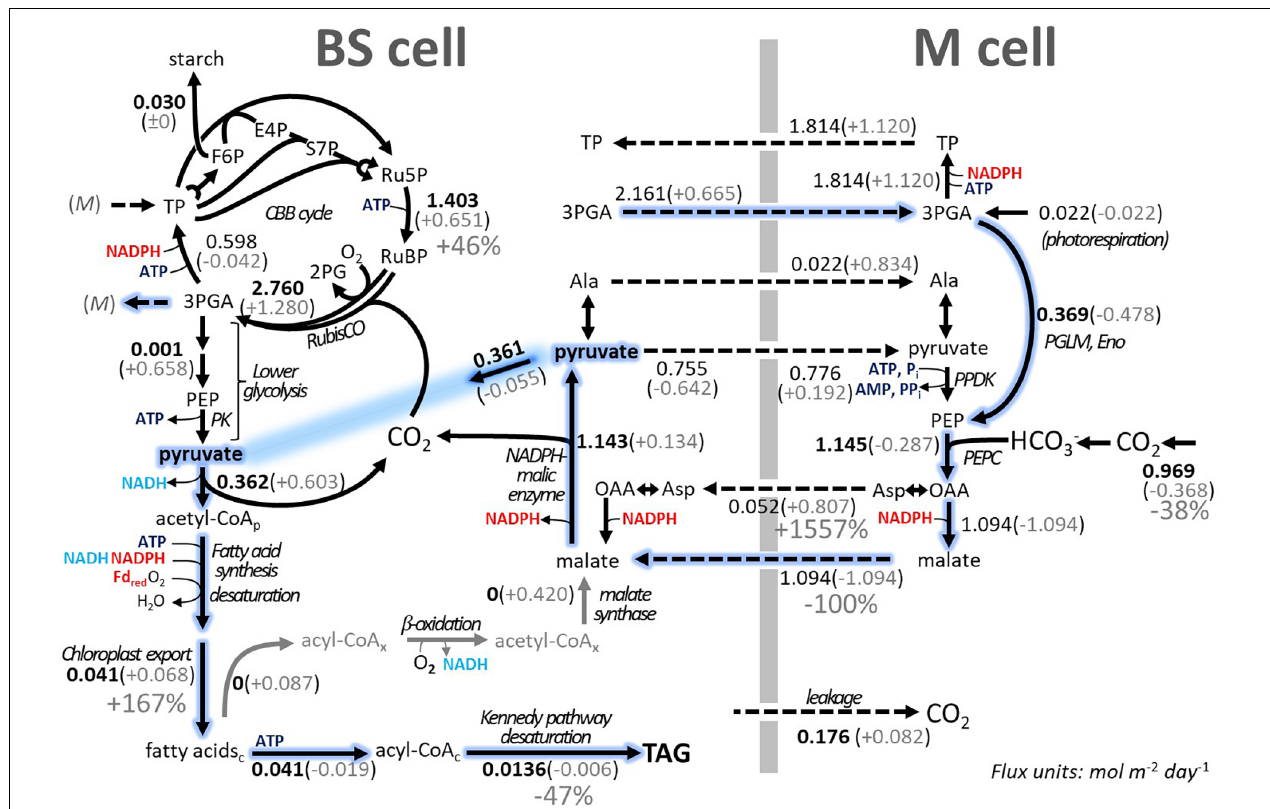
FIGURE 4 | Schematic overview of TAG biosynthesis in the BSC of iTJC1414x4 and impact of fatty acid futile cycling on TAG yield. An uncompartmentalized schematic view of the day sub-models is given summarizing major fluxes, which were predicted based on multilevel optimization (flux projections, see section “Materials and Methods”). Bolded flux values are invariable in the FBA solution space. Flux units are mol m − 2 day − 1 and complete flux solutions are listed in Supplementary Table 7 . Gray values given in parentheses are changes in flux values upon enforcing fivefold cycling [i.e., fatty acid biosynthesis / (3 × TAG storage flux) = 5]. Gray arrows summarize the degradation of fatty acids and formation of malate, a process that extends across the cytosol, mitochondrial, and peroxisomal compartments. Dashed arrows indicate metabolite transport through plasmodesmata between cell types. The BSC pyruvate pool is shown twice as emphasized in blue. Also marked in blue is a scheme where generation of pyruvate destined to fatty acid synthesis intersects with the 3PGA/triose phosphate shuttle and the C 4 shuttle. Subscripts “c,” “p,” and “x” indicate metabolites specific to the cytosolic, plastidic, and peroxisomal compartment, respectively. 3-PGA,